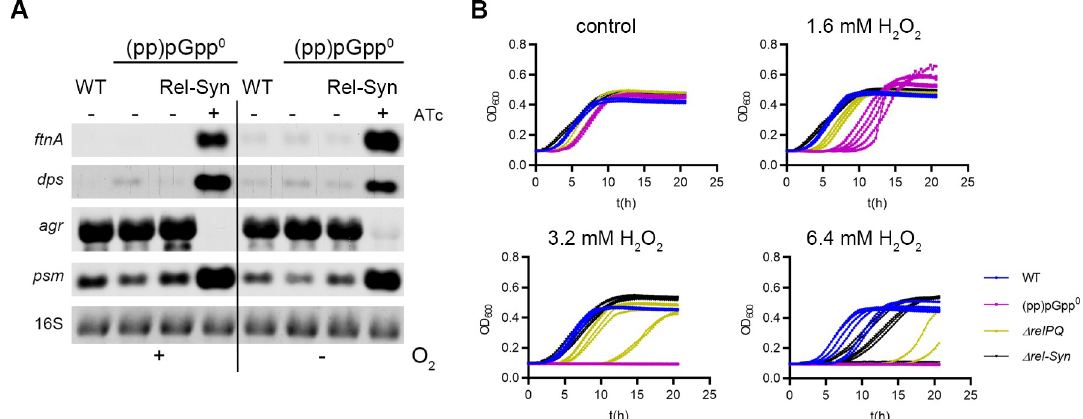
Fig 6. Functional link between stringent response and oxidative stress. A . Strain HG001 and derivatives were grown with shaking aerobically or anaerobically to OD 600 = 0.3 and treated for 30 min without or with 0.1 μ g/ml ATc (mutant with inducible rel-Syn ). For Northern blot analysis, RNA was hybridized with digoxigenin-labelled probes specific for ftnA , dps , psm or agrA . The 16S rRNA detected in ethidium bromide-stained gels is indicated as a loading control in the bottom lane. B WT, (pp)pGpp 0 , Δ relPQ and rel-Syn mutants were diluted from overnight culture to an OD = 0.1, challenged with different H 2 O 2 concentrations, and growth was monitored over